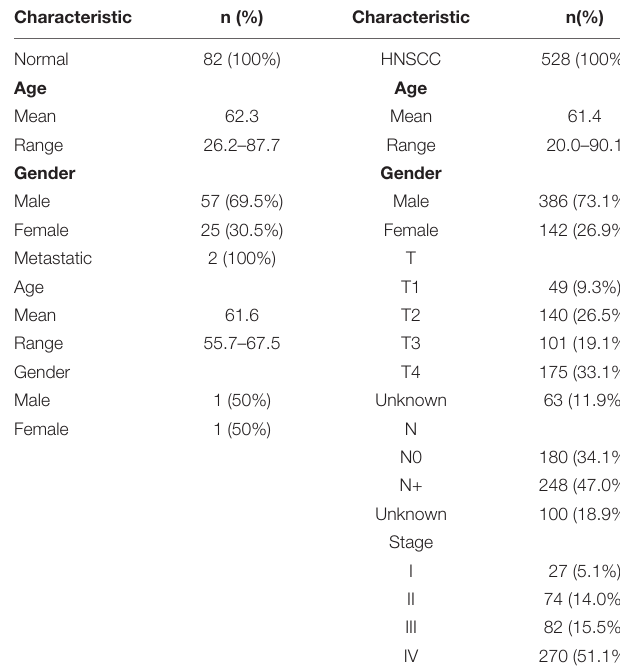
TABLE 1 | Baseline characteristics of the cancer genome atlas (TCGA)